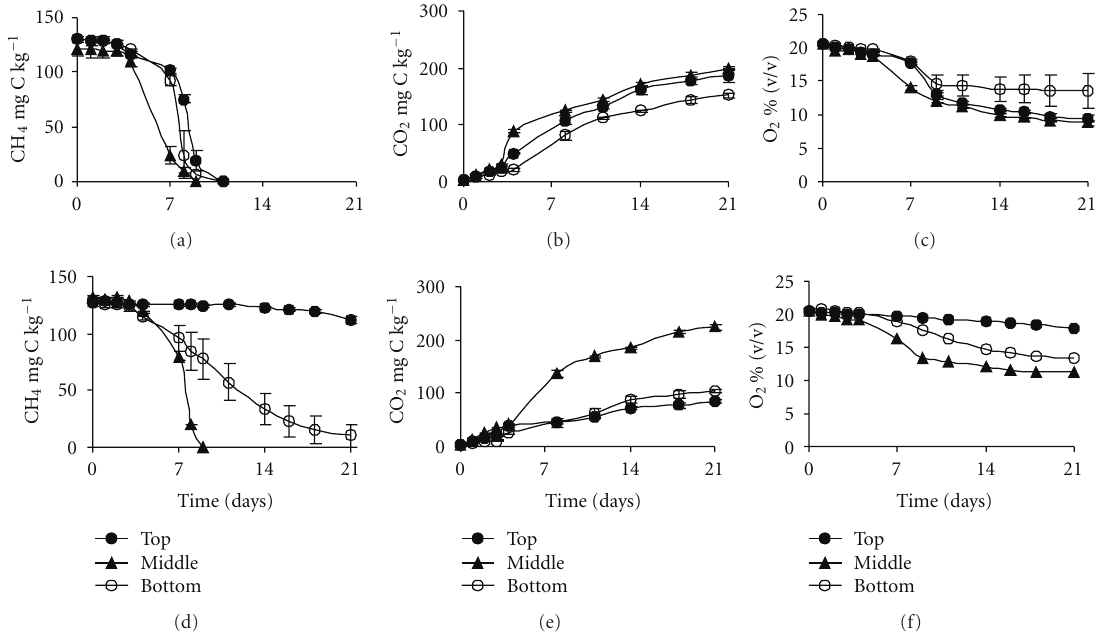
Figure 2: Changes of CH 4 , CO 2 , and O 2 over time in loess soils collected from three slope positions and incubated with added methane, 5kPa (methanotrophic potential). Top: summit, Middle: back slope, Bottom: bottom of the slope. Upper graphs (a–c) upper soil depth of 0–20cm; lower graphs (d–f) lower soil depth of 20–40 cm. (a) and (d) cumulative CH 4 production; (b) and (e) cumulative CO 2 production; (c) and (f)—changes in O 2 in the headspace. Points represent triplicate-means with standard error.